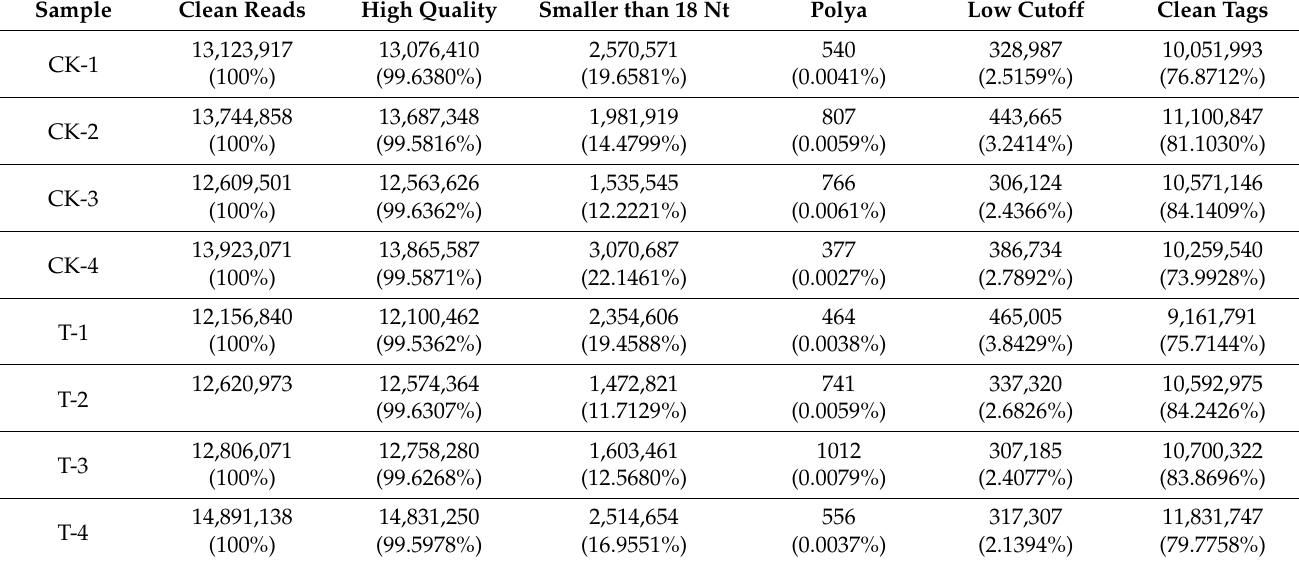
Table 2. Summary of sequence data generated for HepaRG cells’ small RNA and quality filtering.